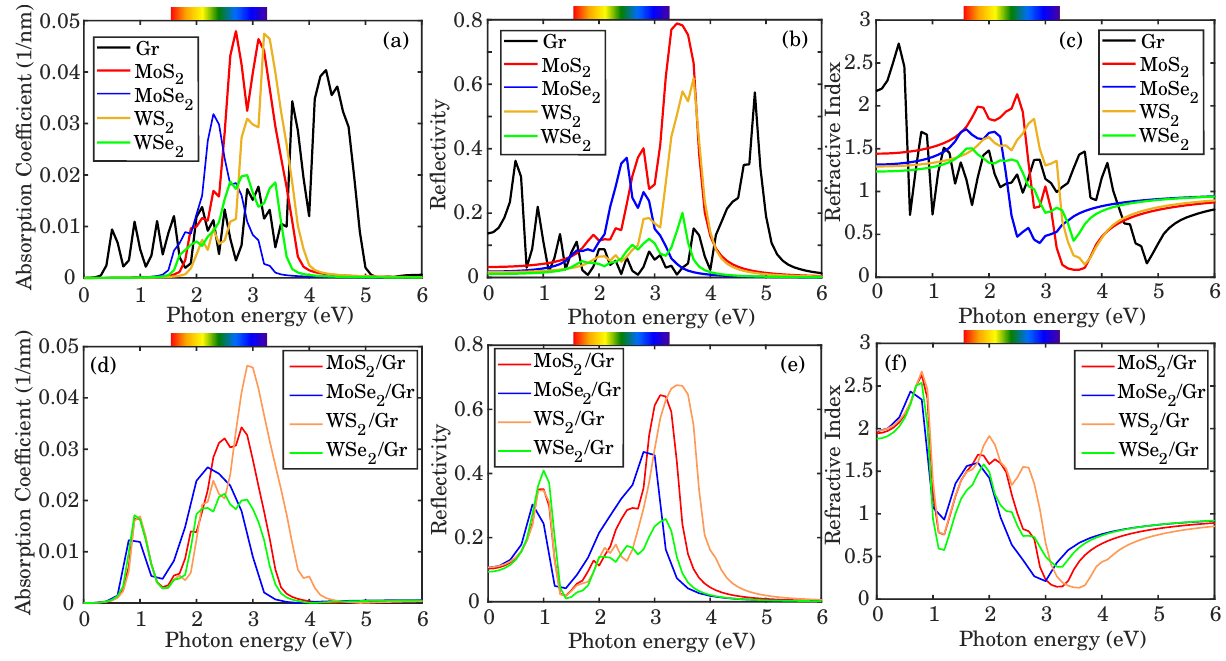
Figure 4. The comparison of MX 2 /Gr heterostructures and MX 2 and Gr monolayers according to their ( a , d ) absorption coefficient α , ( b , e ) reflectivity R and ( c , f ) refractive index n . The rainbow bars represent the energy range of visible light, from 1.59 eV to 3.26